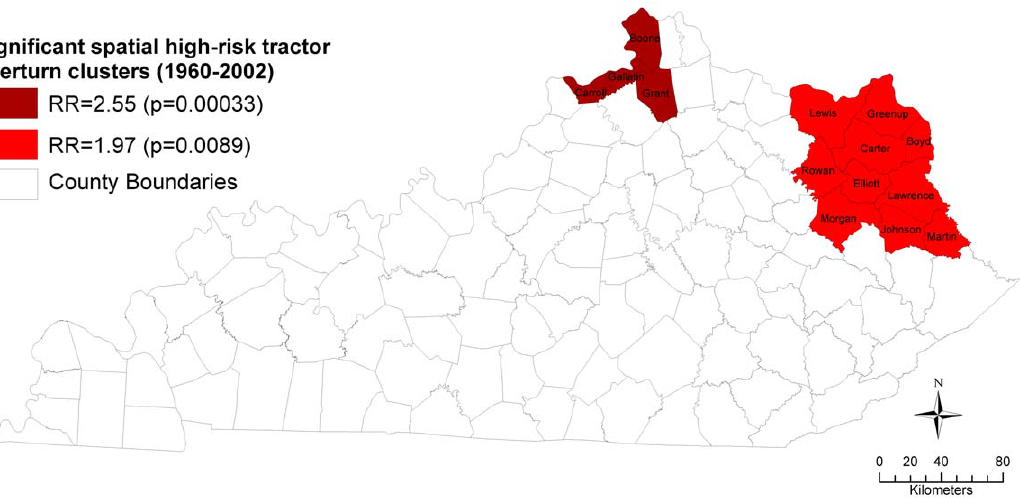
Figure 3. Significant spatial high-risk tractor overturn clusters in Kentucky, 1960–2002. Note: RR=relative risk; Interpreted as increased risk inside relative to outside the cluster. doi:10.1371/journal.pone.0030532.g003 PLoS ONE |